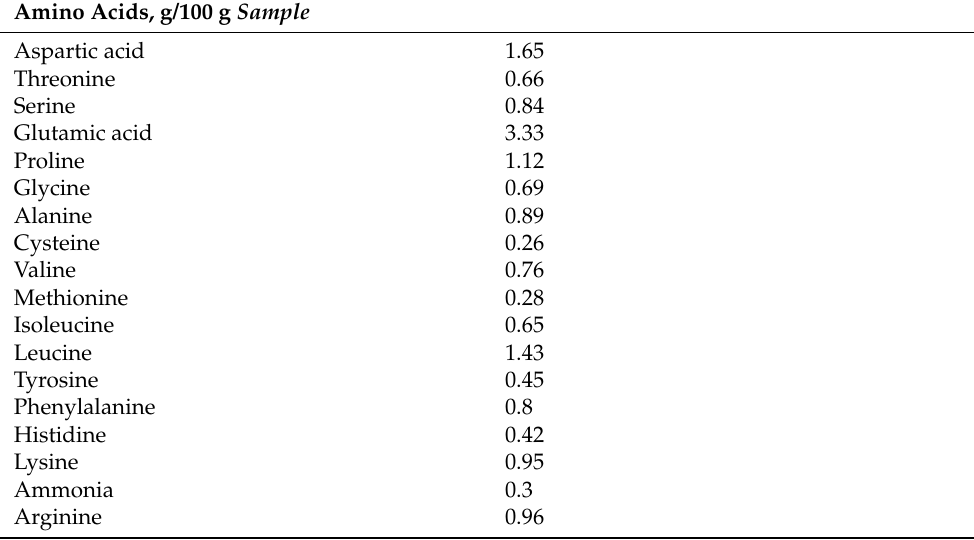
Table 3. Analyzed amino acids in experimental feed for cannulated-fattening pigs.